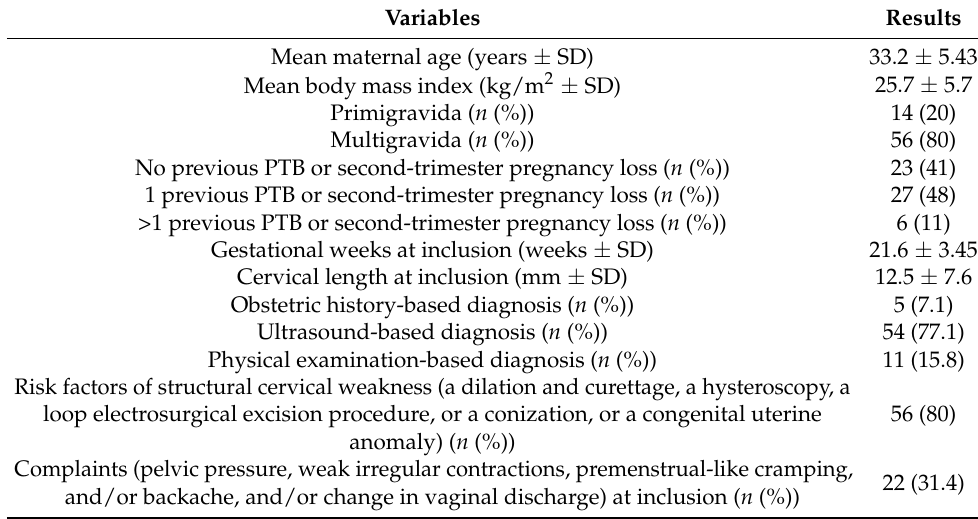
Table 1. The baseline characteristics of the study population ( n = 70).